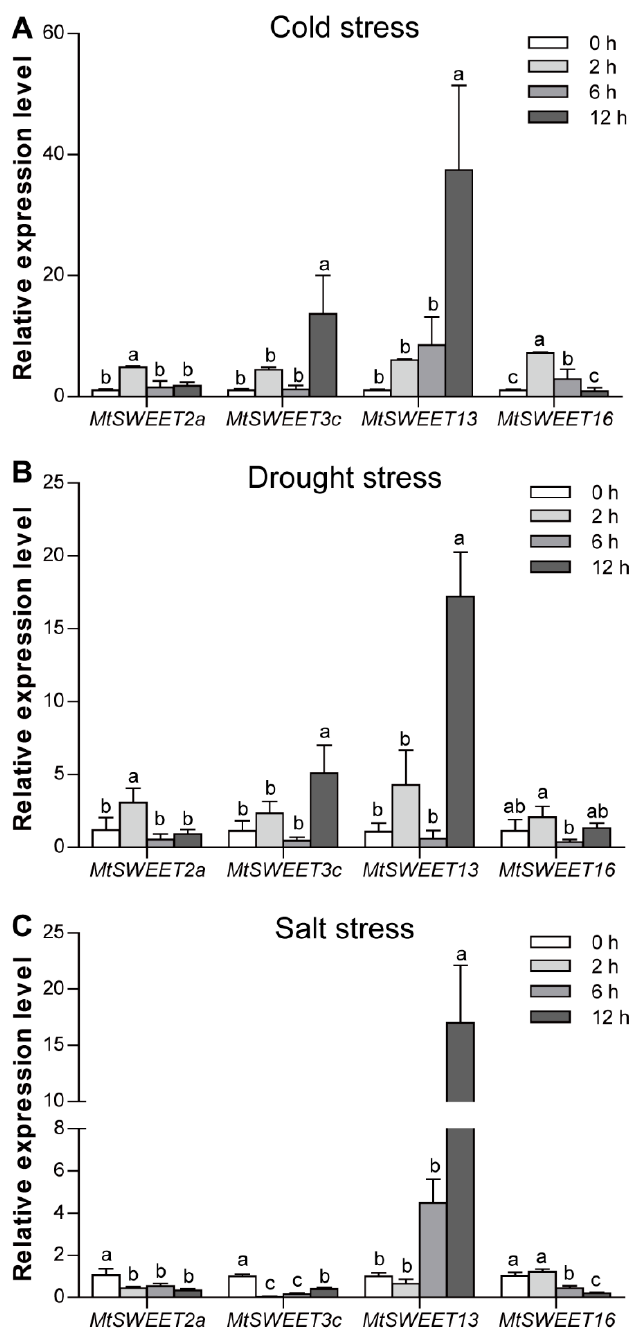
Figure 7. Expression levels of four selected MtSWEET genes in response to cold ( A ), drought ( B ), and salt ( C ) stress conditions. Expression of the genes at 0 h was set as 1, and different letters indicate statistically significant differences (Duncan’s test, p < 0.05).